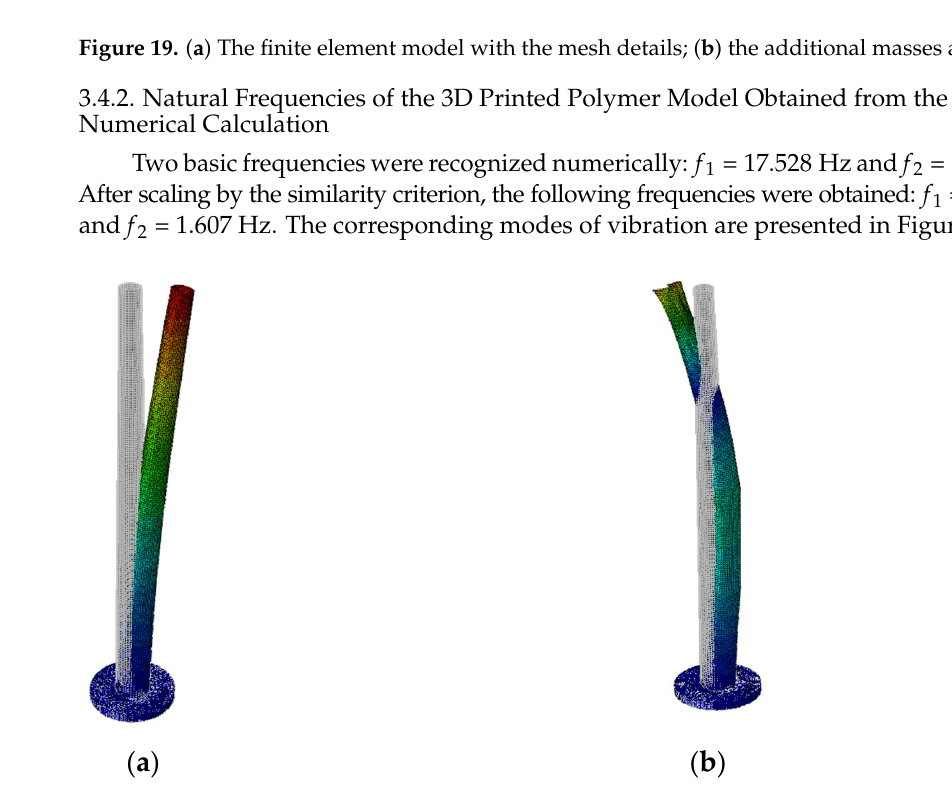
Figure 20. Basic modes of vibration obtained numerically: ( a ) First mode corresponding to frequency f 1 = 0.360 Hz; ( b ) second mode corresponding to frequency f 2 = 1.607 Hz.